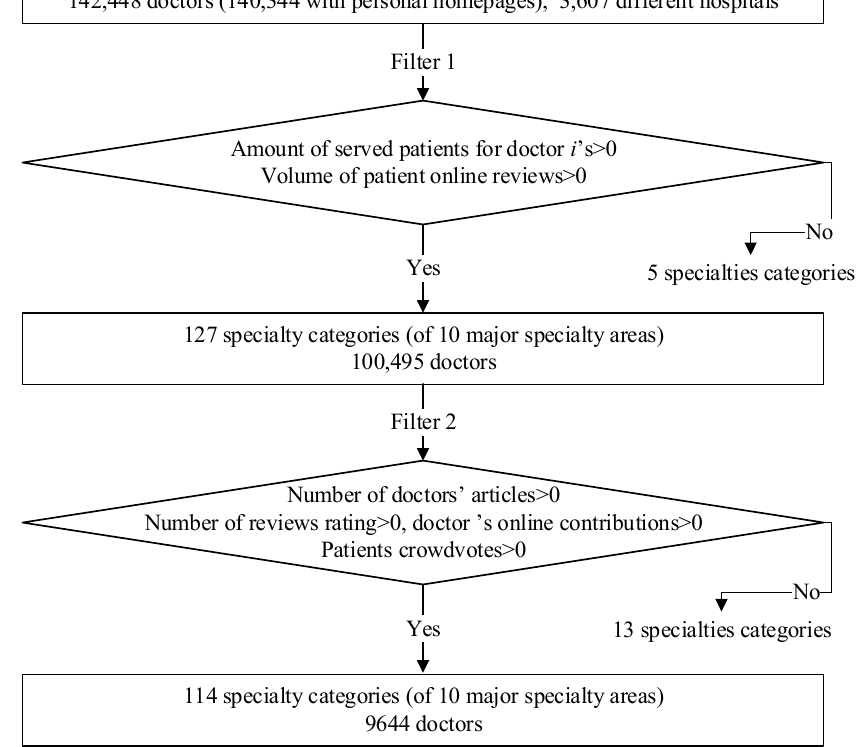
Figure 2. Data Acquired and Filtering Process (Accessed From Good Doctor Website).